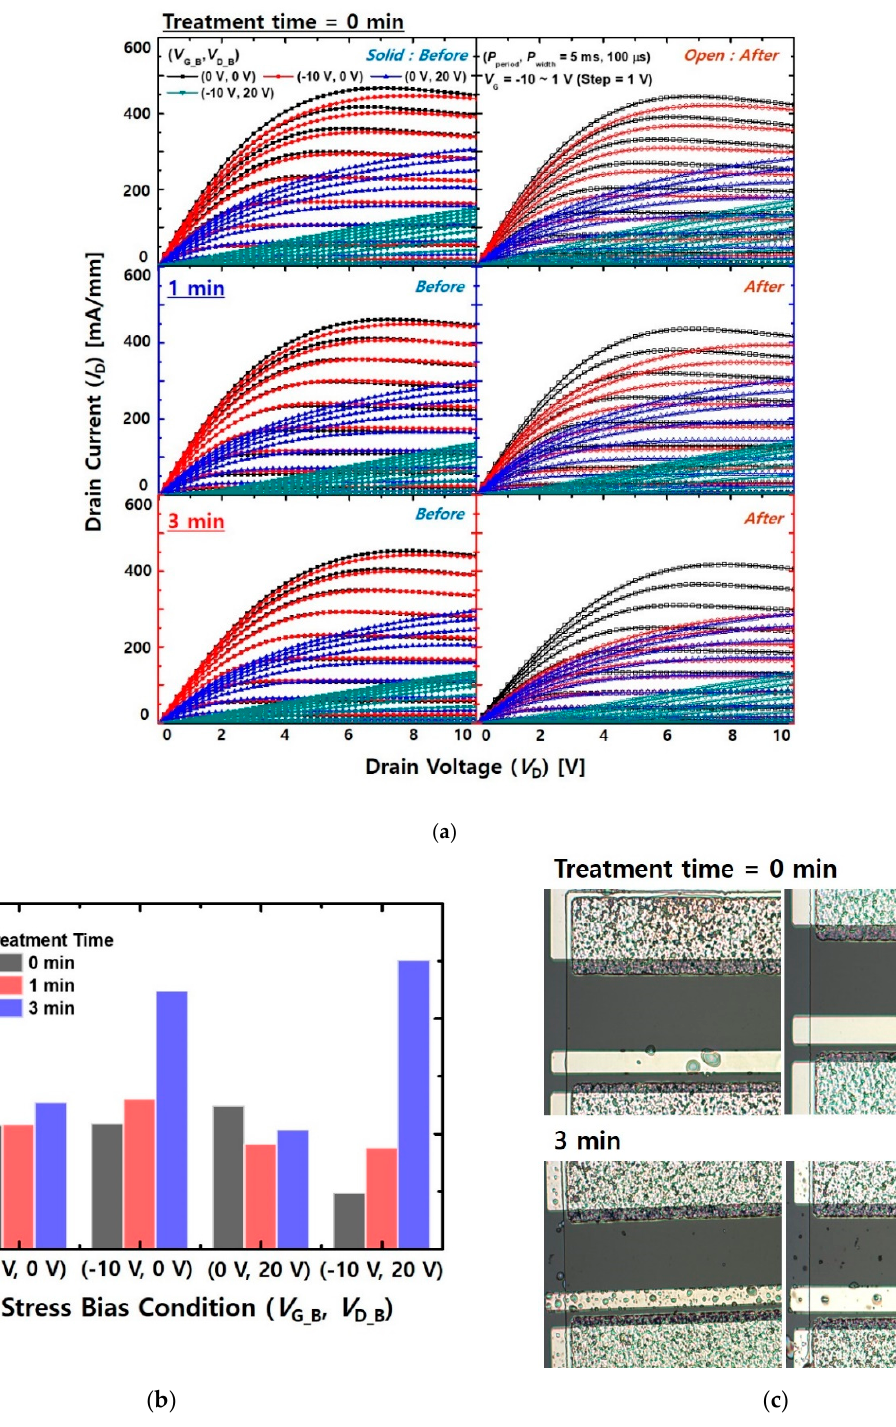
Figure 7. ( a ) Current collapse characteristics of the MIS ‐ HEMTs before and after proton irradiation. ( b ) Variation rates of R on depending on different stress bias conditions. The V G_B and V D_B were (0 V, 0 V), ( − 10 V, 0 V), (0 V, 20 V), and ( − 10 V, 20 V). The P period and P width were 5 ms and 100 μ s, respectively. The L G , D GS , and D GD of the device were 3, 5, and 5 μ m, respectively. ( c ) Optical microscope image after irradiation of the devices with and without treatment.